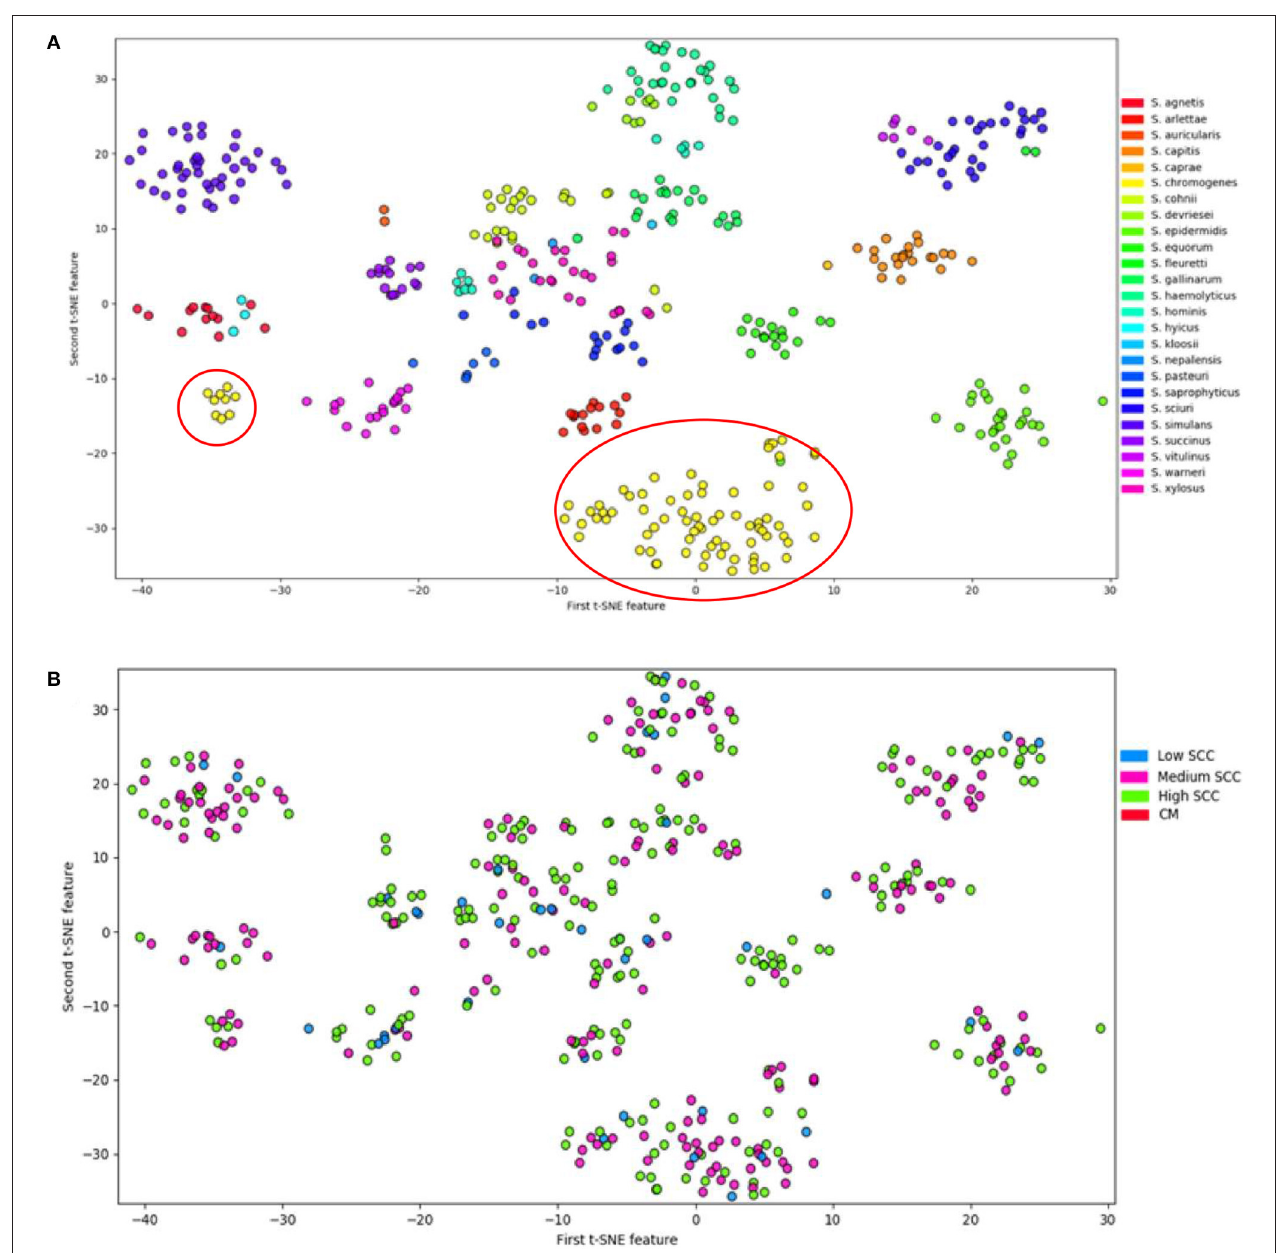
FIGURE 2 | Visualization of 25 NAS species by t-Distributed Stochastic Neighbor Embedding (T-SNE) based on virulence gene content, demonstrating that each of the NAS species is a discrete microorganism; the red circles indicate the distinctive split between S. chromogenes populations (A) . Labeling of severity of mastitis of the NAS isolates separated based on virulence genes (B) . Modified from